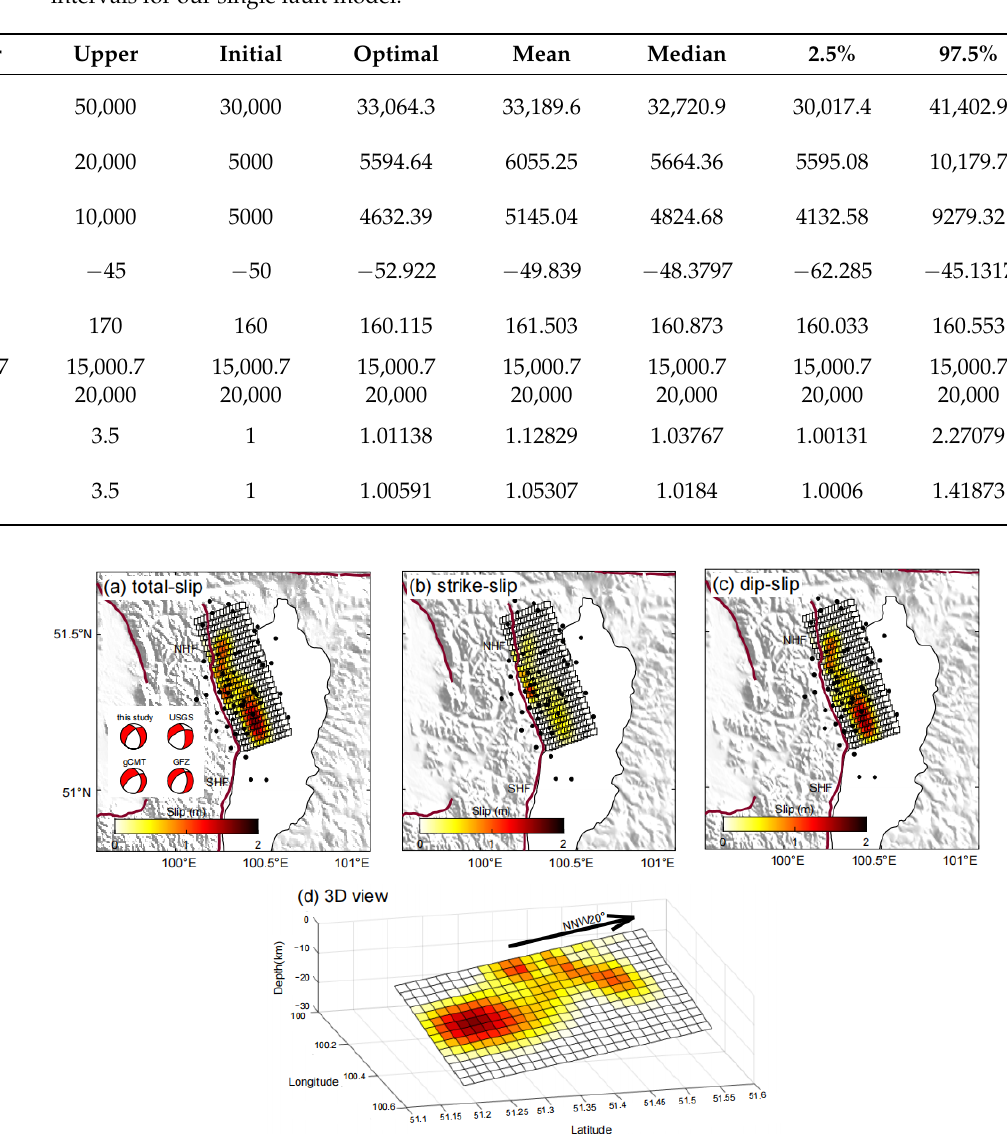
Table 3. The prior and initial values, maximum posterior probability solutions, and confidence intervals for our single fault model.